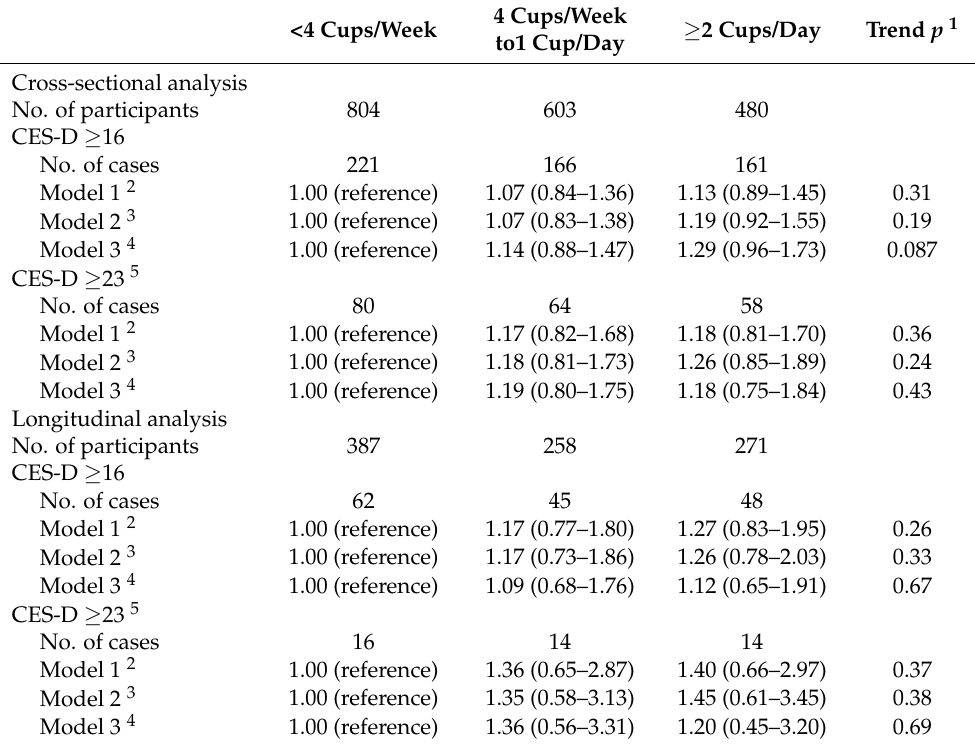
Table 2. Odds ratio (95% confidence intervals) of depressive symptoms by category of green tea consumption in cross-sectional and longitudinal